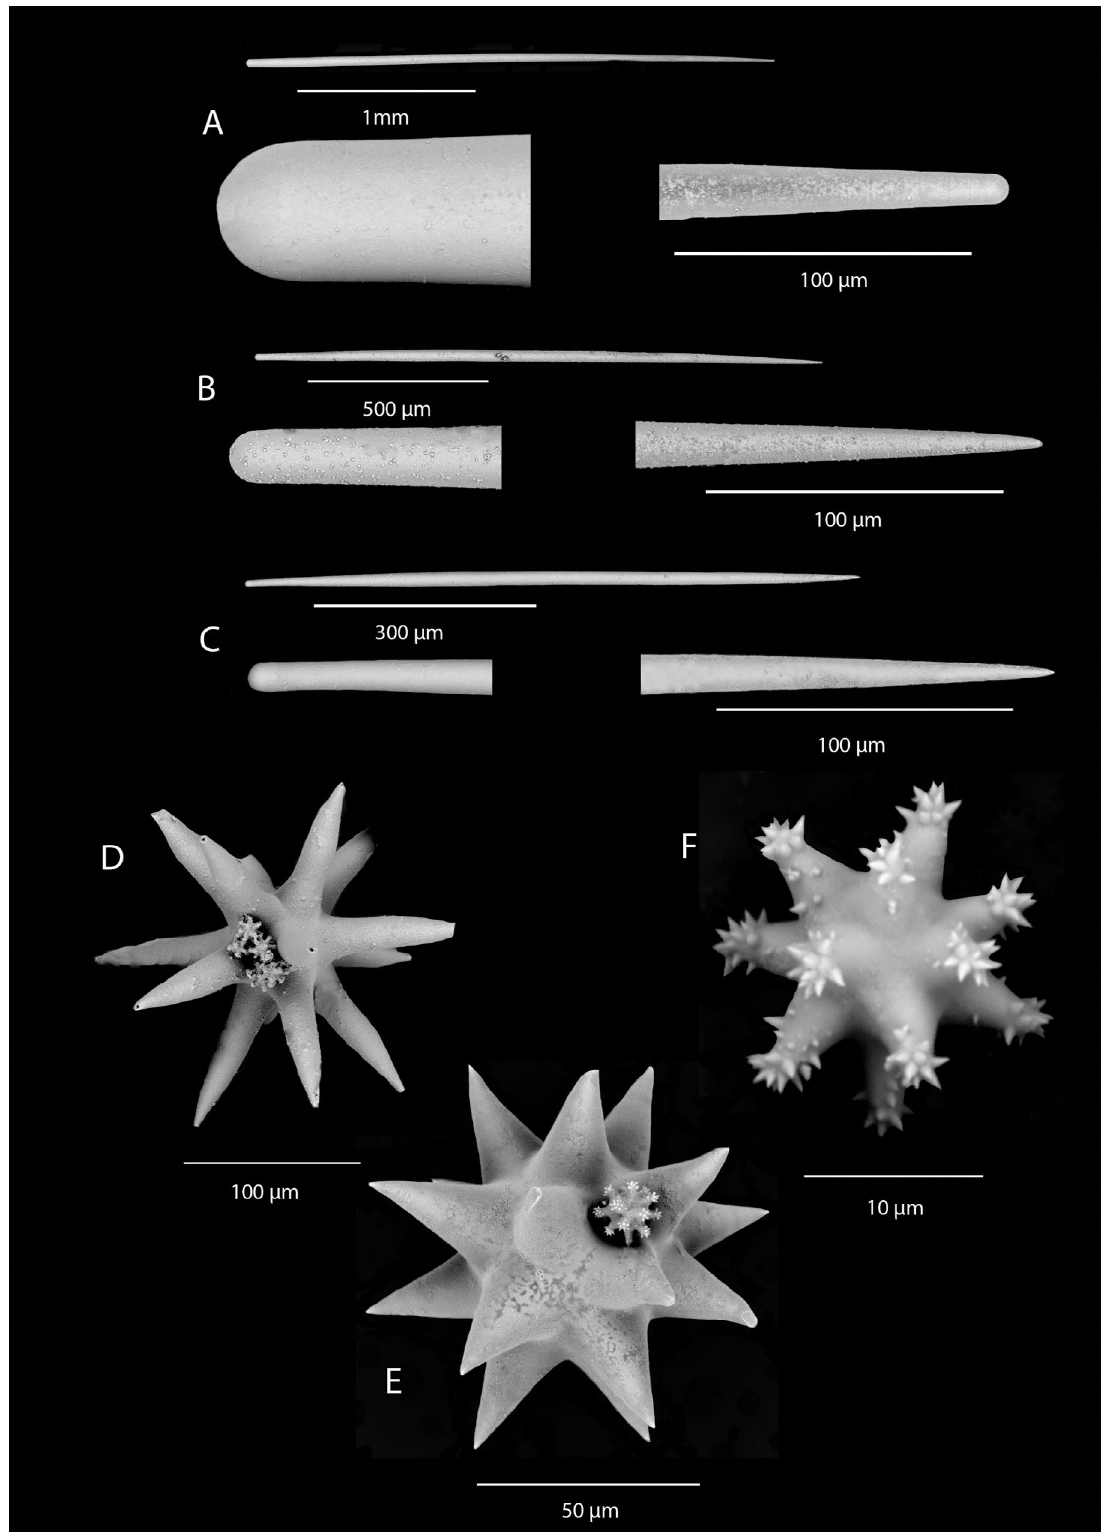
Fig. 3. Tethya irisae sp. nov. spicules. A – B . Straight style/strongyloxeas. C . Subtylostyle. D . Long-rayed oxyspheraster. E . Short-rayed oxyspheraster with small acanthooxyspheraster. F .